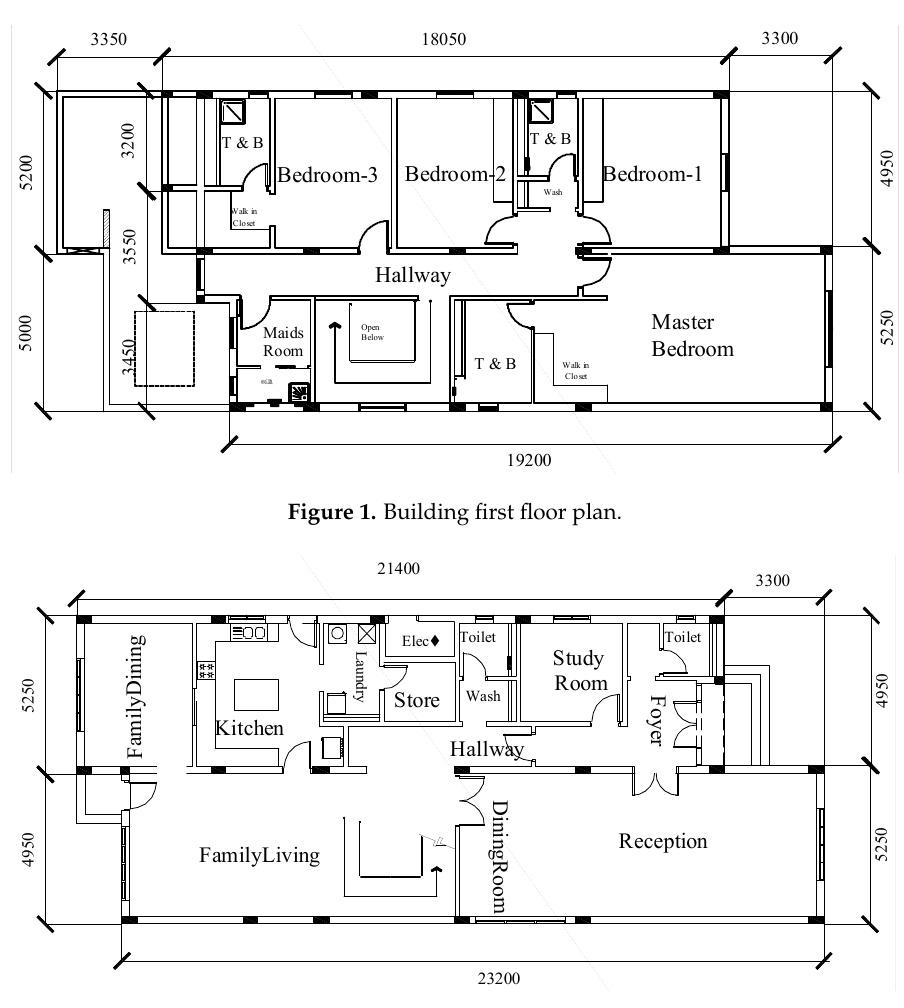
Figure 2. Building ground floor plan. Table 1. Key structural features of the